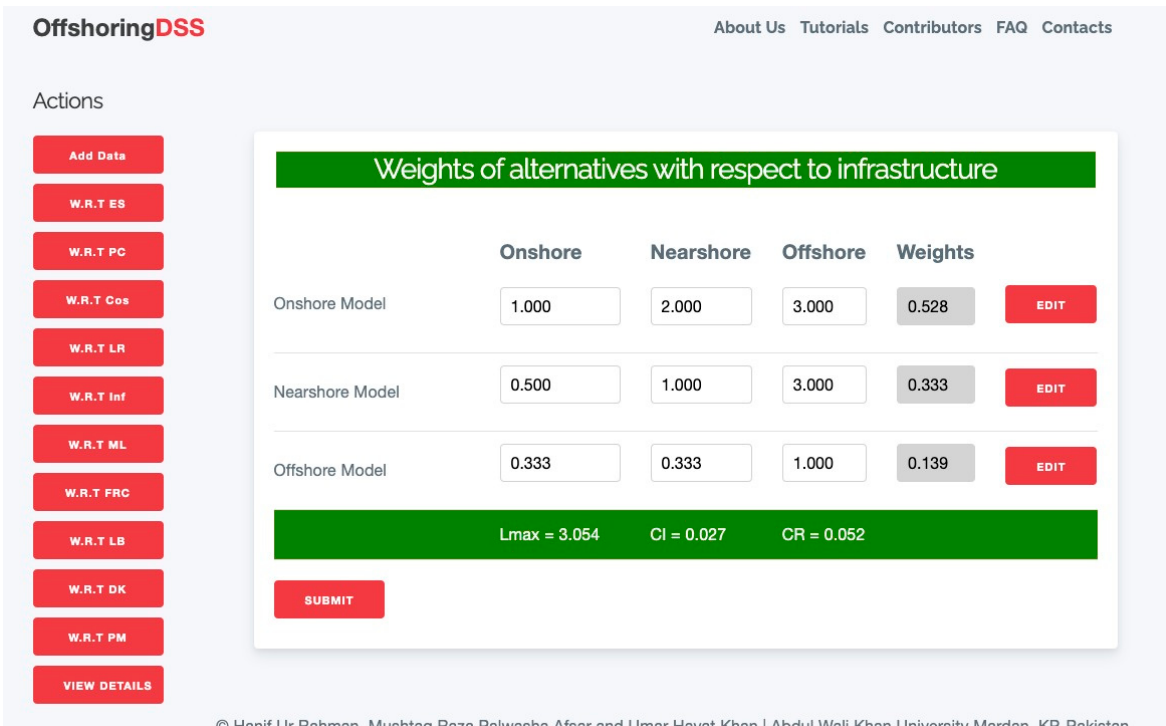
Figure A3. Alternatives weights with reference to LR and CR.